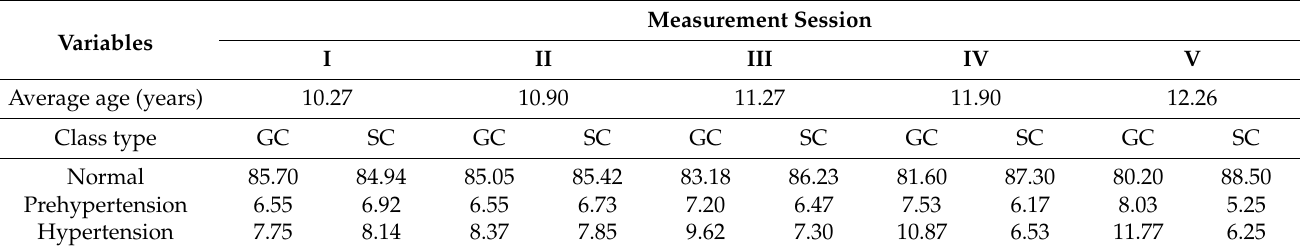
Table 4. The changes in the percentage of children in particular diastolic blood pressure categories from the initial to the final measurement sessions